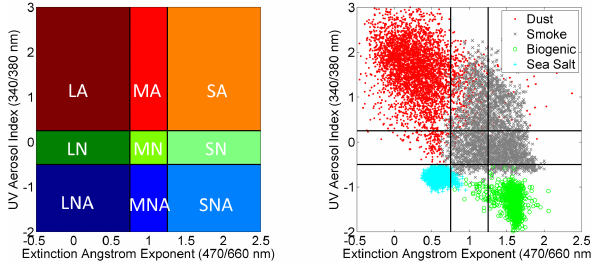
Figure 1. Speciation of aerosol types based on absorption (UVAI) and size (EAE). Left, aerosol types color-coded according to size (larger sizes have darker hues) and absorption (non-absorbing in blue, neutral in green, absorbing in red): LA, large absorbing; MA, medium-size absorbing; SA, small absorbing; LN, large, neutral; MN, medium-size, neutral; SN, small, neutral; LNA, large, non- absorbing; MNA, medium-size, non-absorbing; SNA, small, non- absorbing. Right, monthly mean UVAI and EAE within grid boxes in regions dominated by desert dust (red dots), biomass burning smoke (gray crosses), secondary biogenic aerosols (green circles), and sea salt (light blue pluses). Data are from June–August 2007– 2011; see the text for the selected geographical